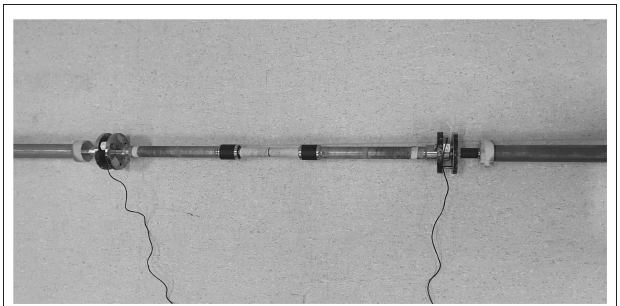
FIGURE 2 | A specially made barbell that included two force cells (Ergotest Technology AS, Langesund, Norway) that could measure the horizontal forces.